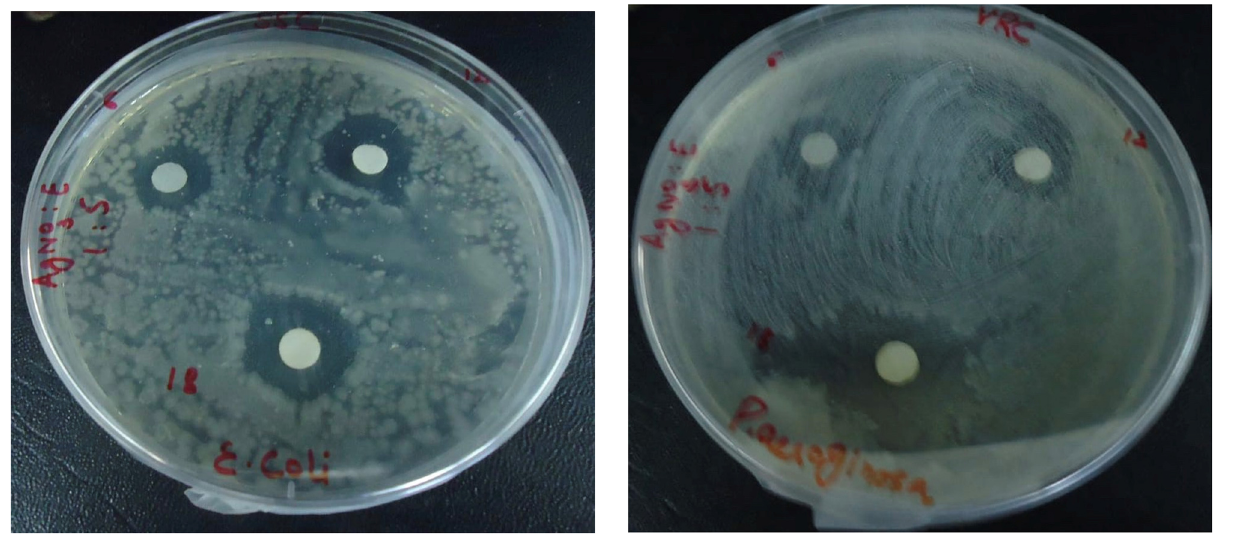
Figure A1: Antibacterial activity of AgNPs and crude methanolic extract of T. govanianum against E. coli by disc di ff usion assay.